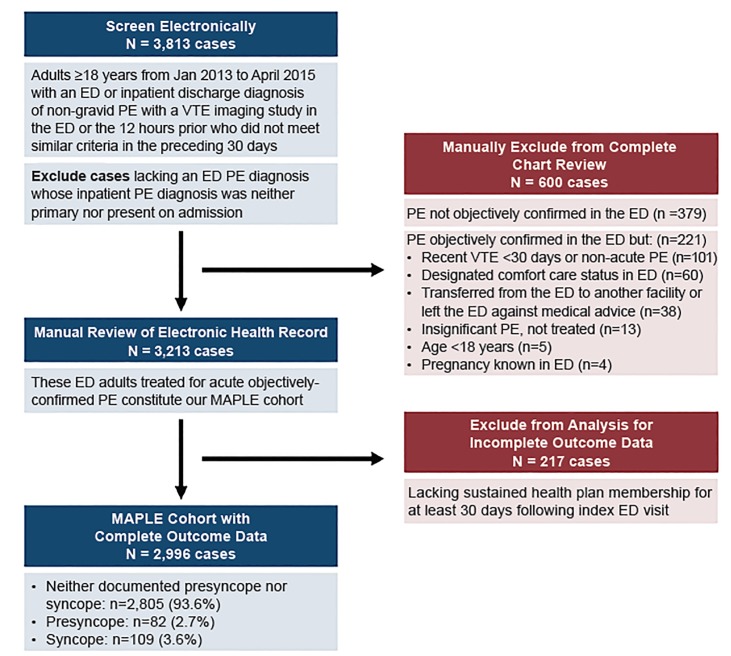
Cohort assembly of emergency department patients with acute pulmonary embolism.ED, emergency department; MAPLE, Management of Acute PuLmonary Embolism study; PE, pulmonary embolism; VTE, venous thromboembolism.